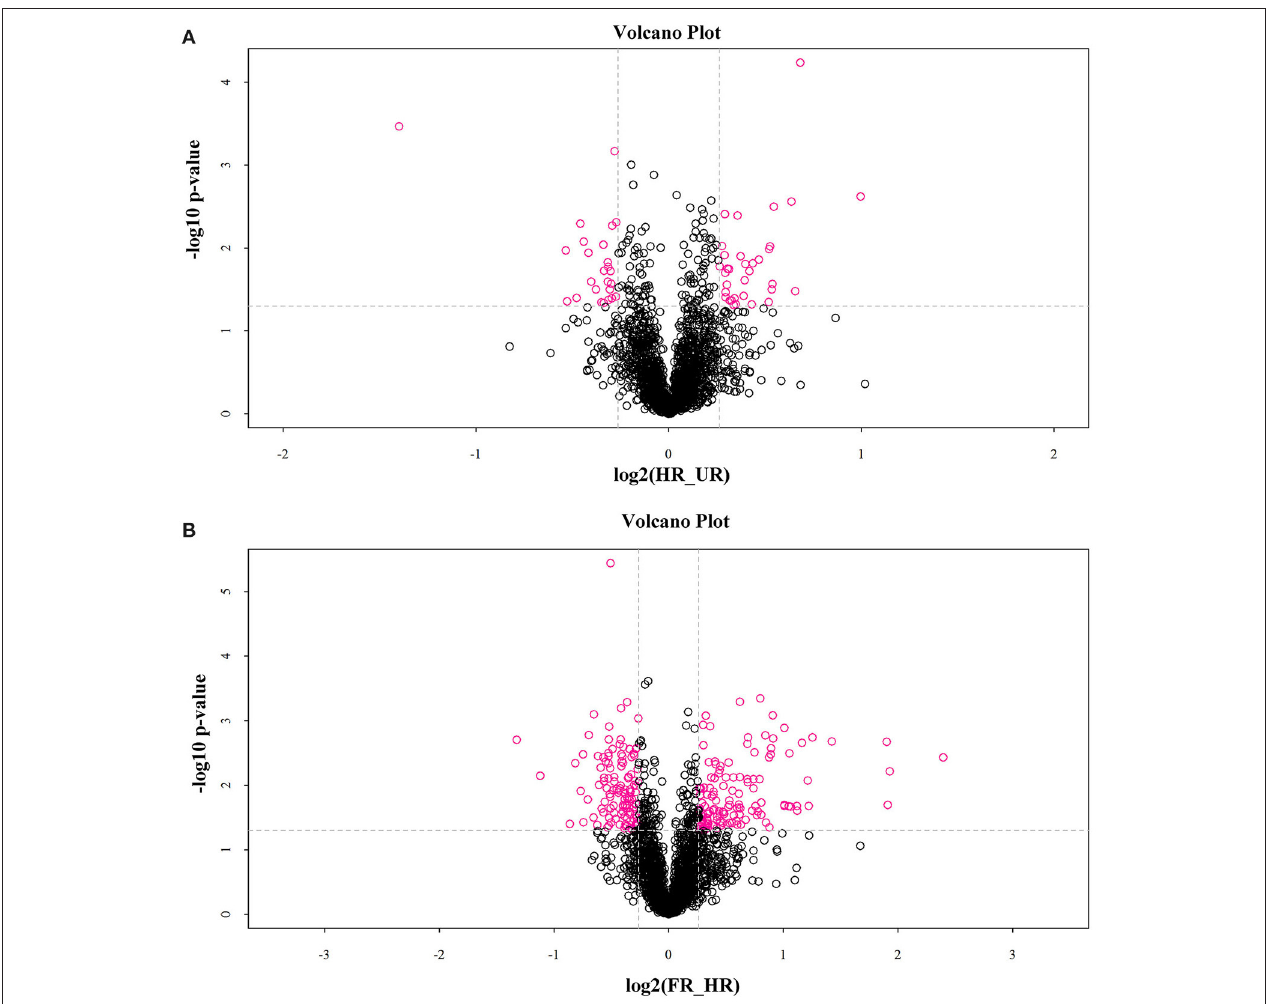
FIGURE 3 | Volcano plot depicting the proteomics data of A. trifoliata . (A) Volcano plot depicting the proteomics data in HR_UR. (B) Volcano plot depicting the proteomics data in FR_HR. Absolute log10 and log2 fold changes are plotted on the y-axis and x-axis, respectively. Horizontal dotted line presents p values of 0.05 cut-off position while the vertical dotted lines discriminate between proteins having absolute log2 fold change of 1. Pink dots represent a log2 fold change > 1 with p < 0.05 in protein expression. Black dots indicate no difference in protein